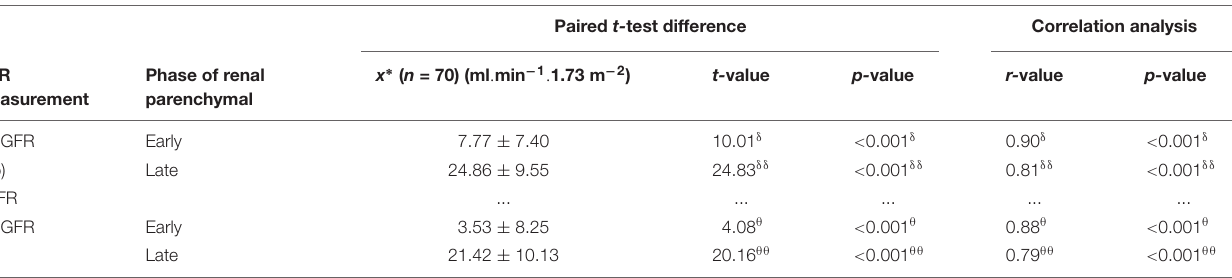
TABLE 2 | Results of statistical comparison between CT-GFR and eGFR.